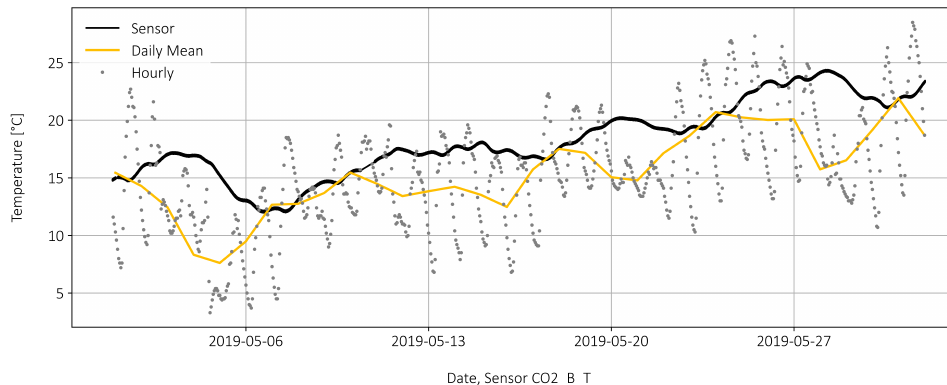
Figure 5. Temperature profile of the sensor in the bridge and temperatures from MeteoSwiss.